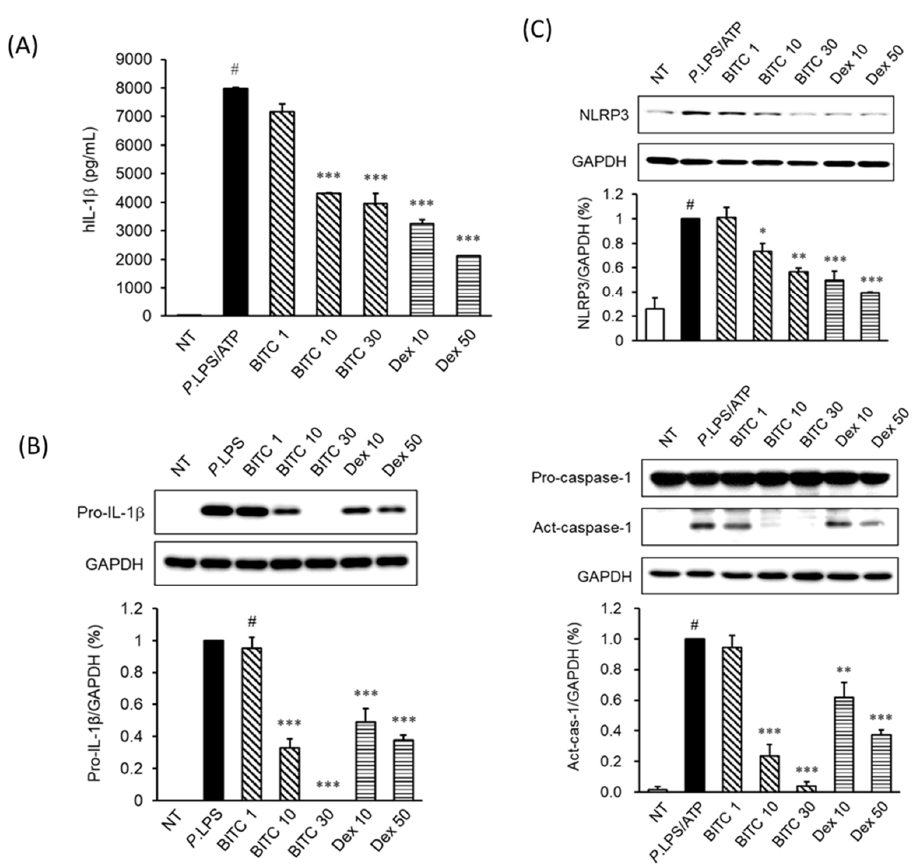
Figure 2. Effects of BITC on IL-1 β production and inflammasome activation in P. aeruginosa LPS/ATP-stimulated primed THP-1 cells. The cells were seeded at 1 × 10 6 cells/mL and incubated with various concentrations (1, 10, and 30 µ M) of BITC for 1 h, followed by P. aeruginosa LPS stimulation (10 µ g/mL). The cells were additionally stimulated with 5 mM ATP for 30 min. After stimulation with P. aeruginosa LPS, IL-1 β production ( A , LPS for 24 h) and pro-IL-1 β expression ( B , LPS for 3 h) were determined via ELISA and western blotting, respectively. ( C ) After treatment with LPS/ATP in the presence or absence of BITC for 1 h, NLRP3 and caspase-1 protein expression were determined using western blotting. Untreated cells were used as a control. Each value indicates the mean ± SD and is representative of results obtained from three independent experiments. # p < 0.05 vs. untreated group (NT); * p < 0.05, ** p < 0.01, *** p < 0.001 vs. P. aeruginosa LPS